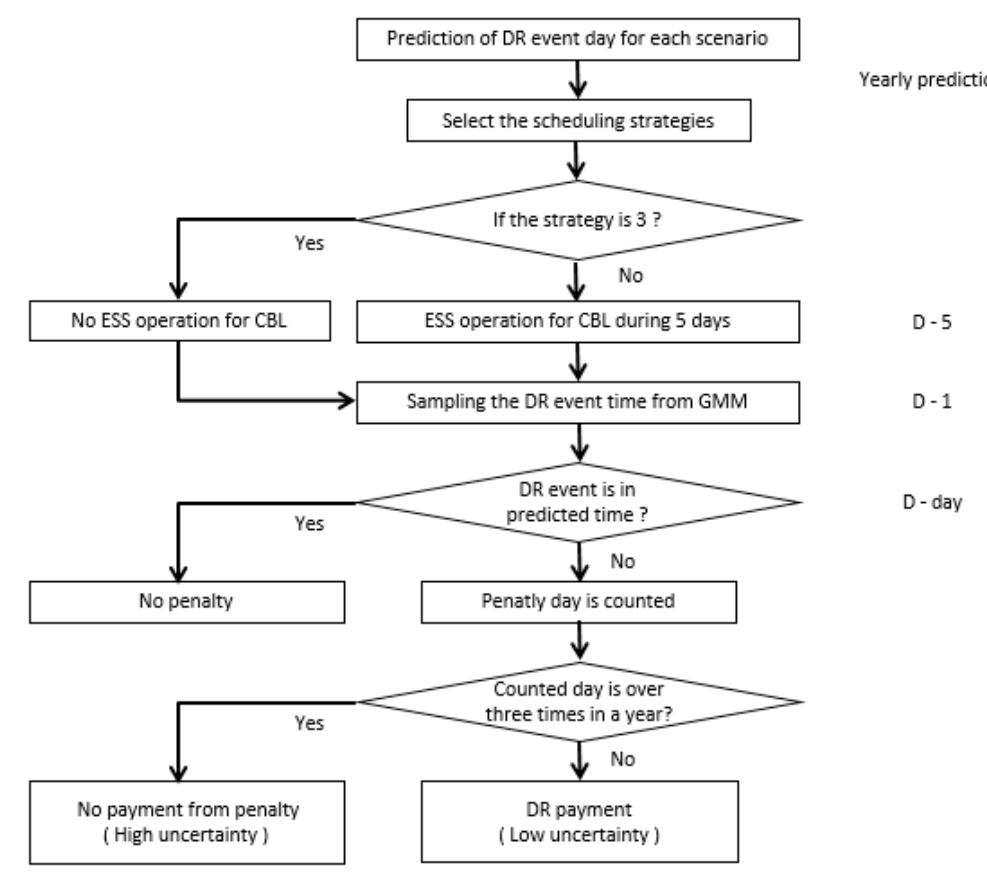
Figure 4. DR participation process with ESS.